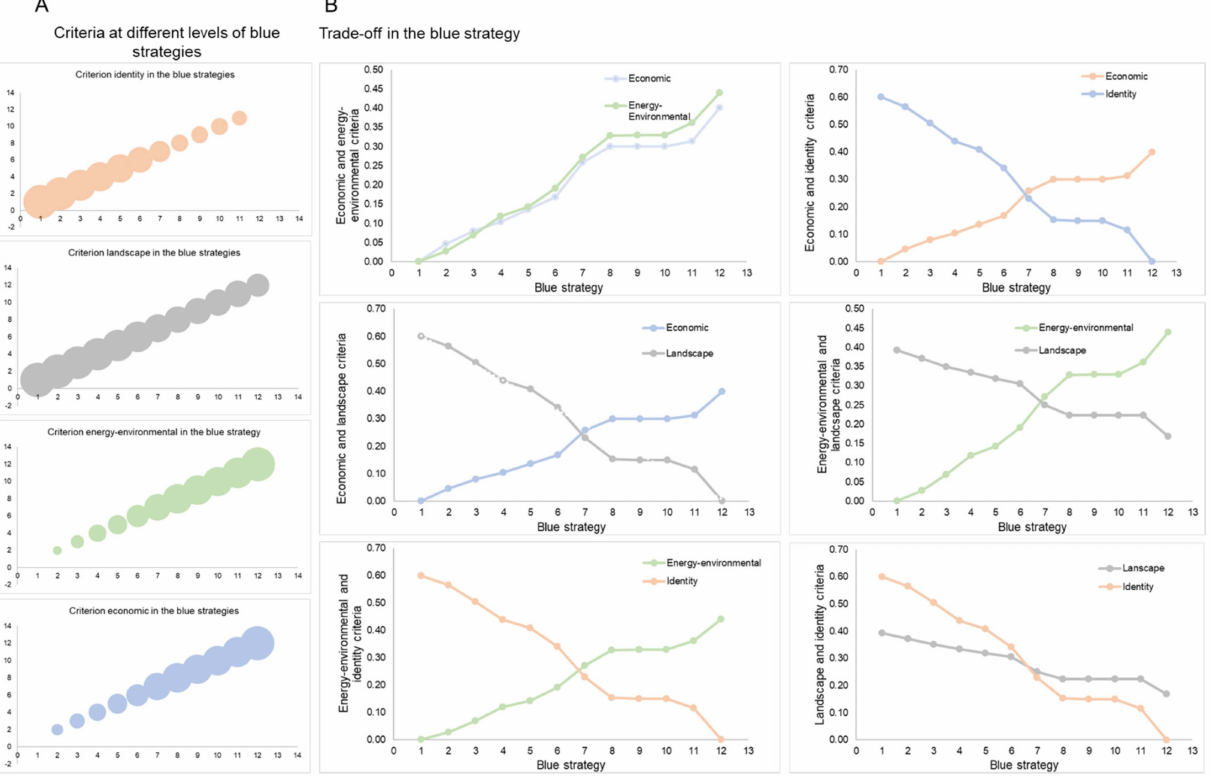
Figure 7. ( A ). Values of the criteria for the different levels of the blue strategy. ( B ). Trade-off between the criteria for the set of weights selected by the decision